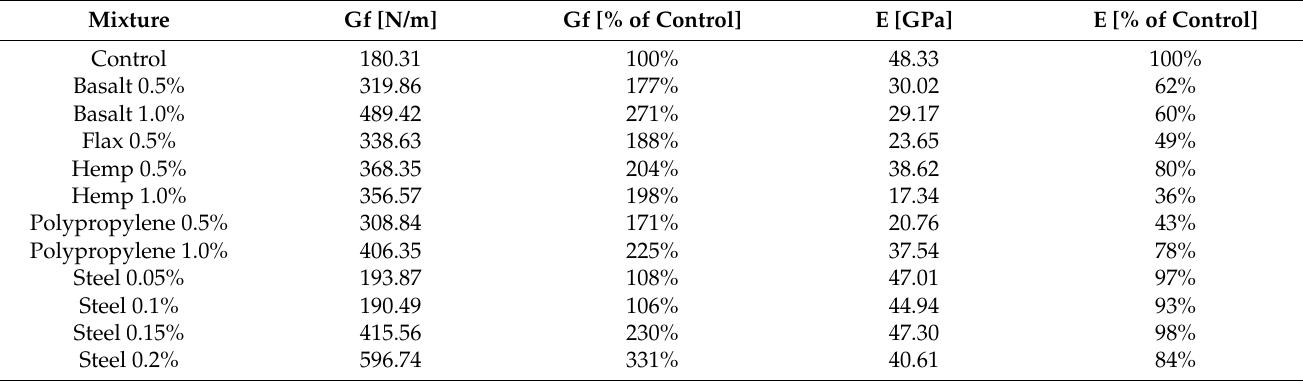
Table 7. Fracture energy and elastic modulus from the three-point bending